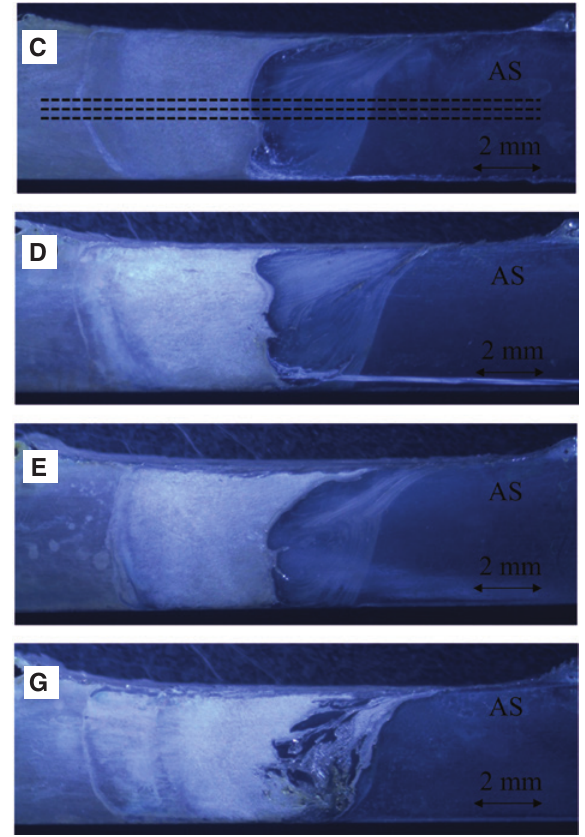
Figure 9: Cross-sectional macrostructures of the joint samples S2 or (a) to S9 or (h), cut from interface varied weld coupon shown in Figure 5. (C) Cross-sectional macrostructure of the joint sample S4. (D) Cross- sectional macrostructure of the joint sample S5. (E) Cross-sectional macrostructure of the joint sample S6. (G) Cross-sectional macro- structure of the joint sample S8. Similar defective macrostructures are obtained for samples S2, S3, S7, and